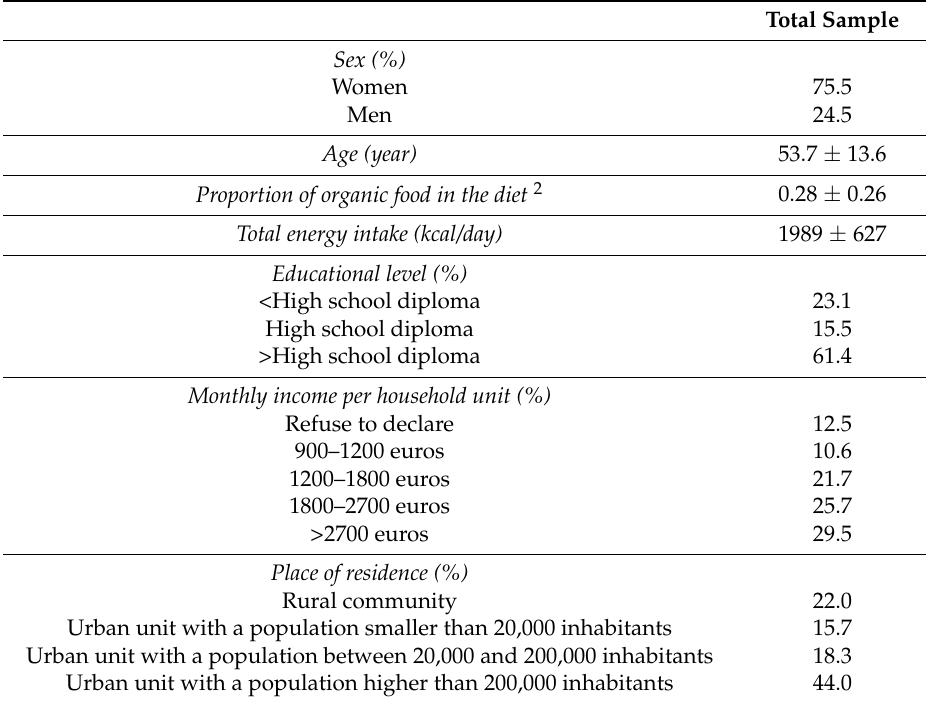
Table 2. Characteristics of the participants, NutriNet-Santé Study, n = 22,966 1